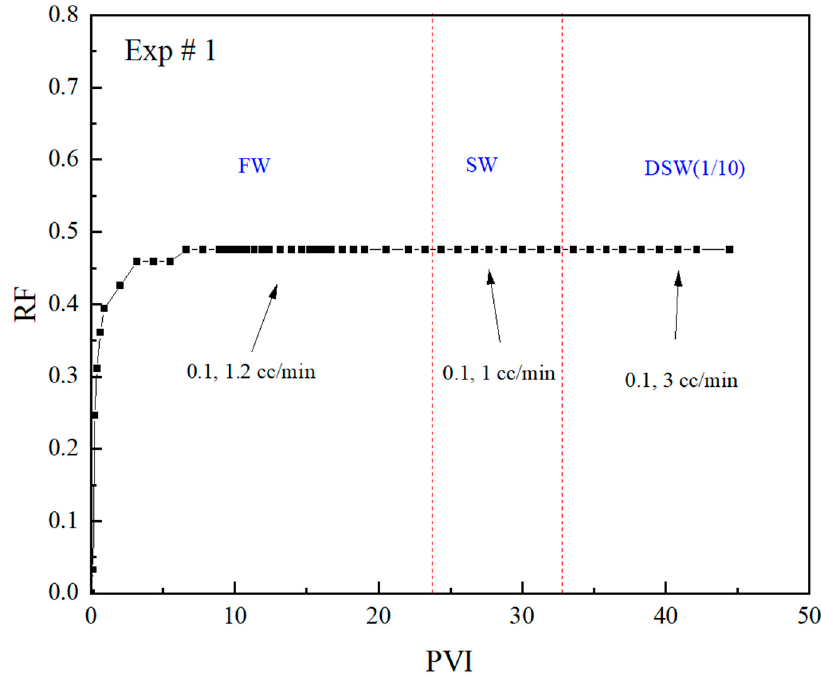
Figure 4. Oil recovery factors on outcrop chalk with hexadecane as the oil phase.